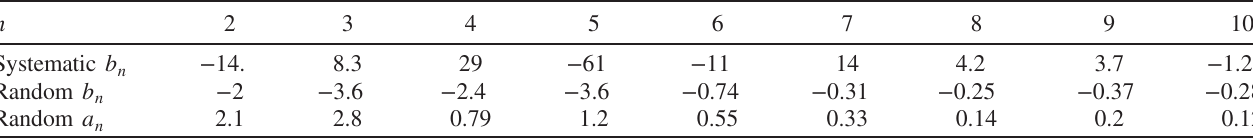
TABLE XI. Hard bends ’ systematic and random higher-order multipole errors relative to the design ( B 1 ¼ 3 . 247 T) dipole field component in units of 10 − 4 (reference radius R ¼ 3 mm).